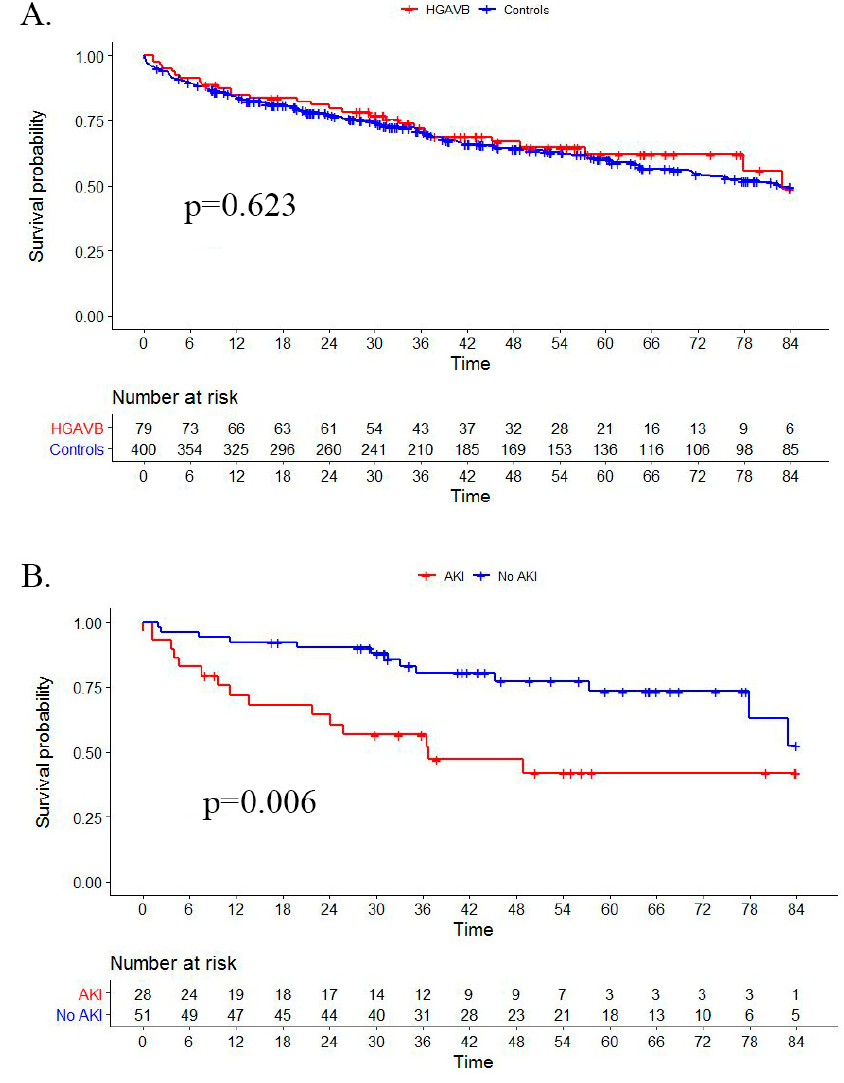
Figure 4. Kaplan–Meier curves of overall mortality among ( A ) patients with HGAVB compared with controls and ( B ) patient with HGAVB with AKI compared to those without AKI.